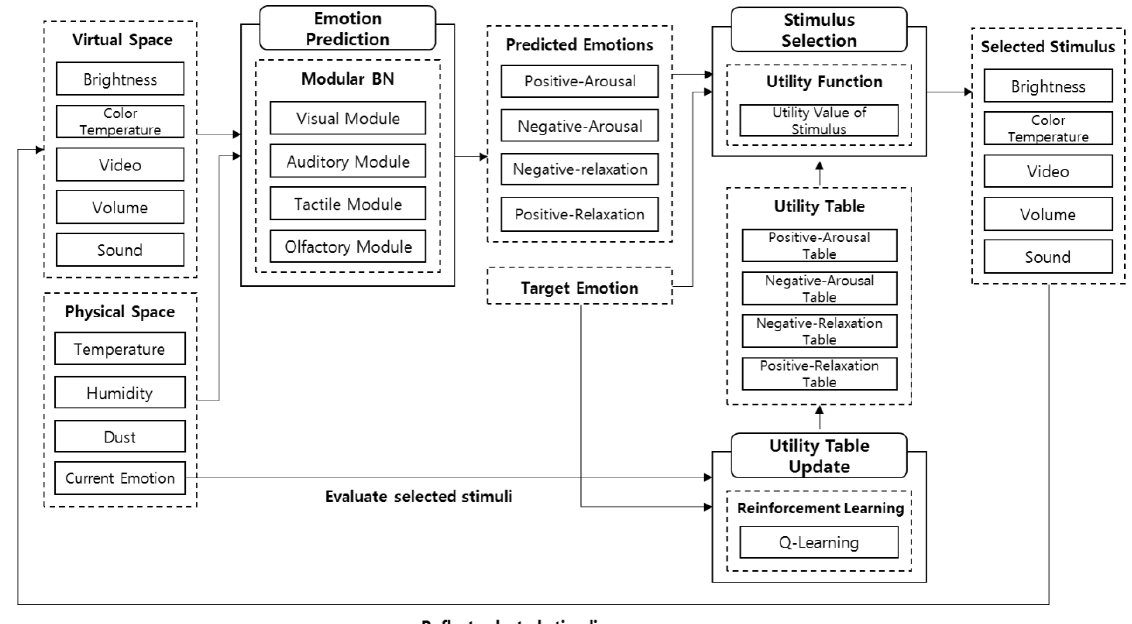
Figure 9. Emotion control system.